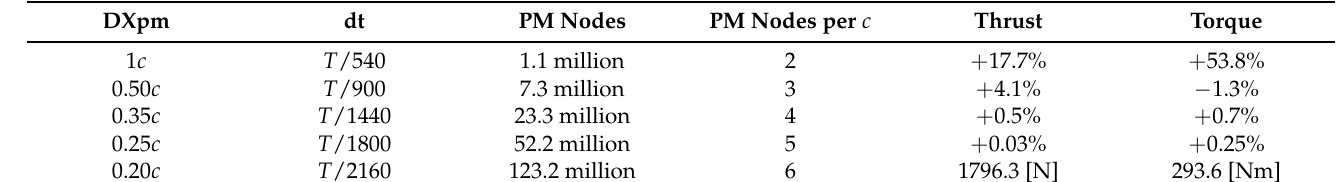
Table 5. Thrust (N) and Torque (Nm) estimation of different PM discretisation lengths. Reference values correspond to minimum value DXpm = 0.20 c .